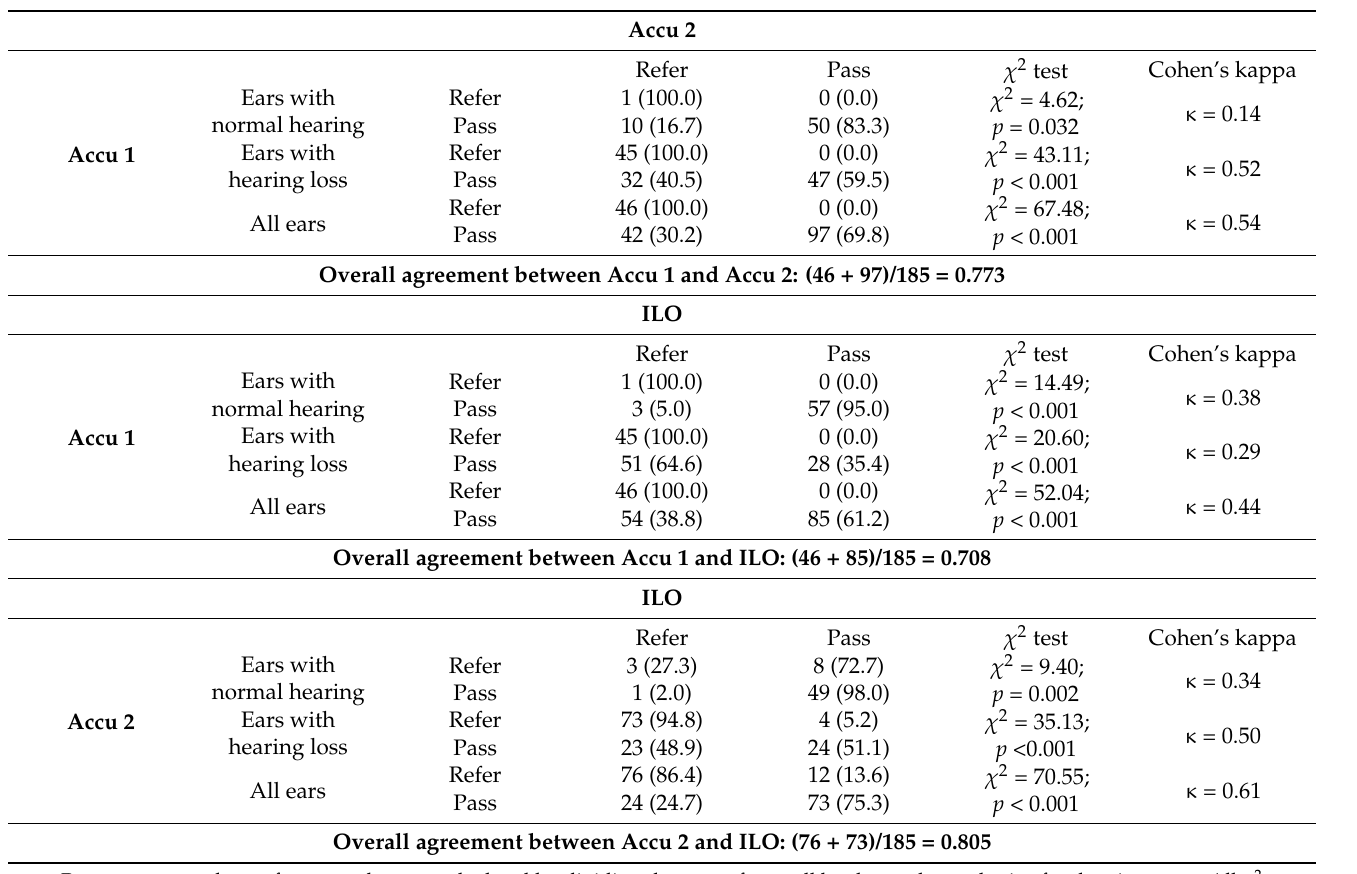
Table 1. Agreement between Accu 1 and Accu 2, and between each of the two devices and ILO. Comparisons show pass/refer rates (number of ears and percent values in brackets), values of chi-square test, and Cohen’s